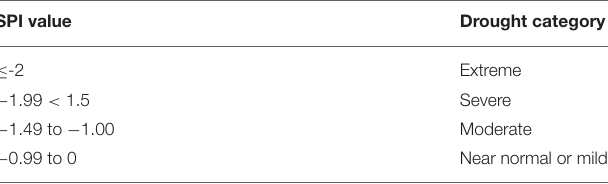
TABLE 2 | Drought categories as defined by SPI value (McKee et al.,